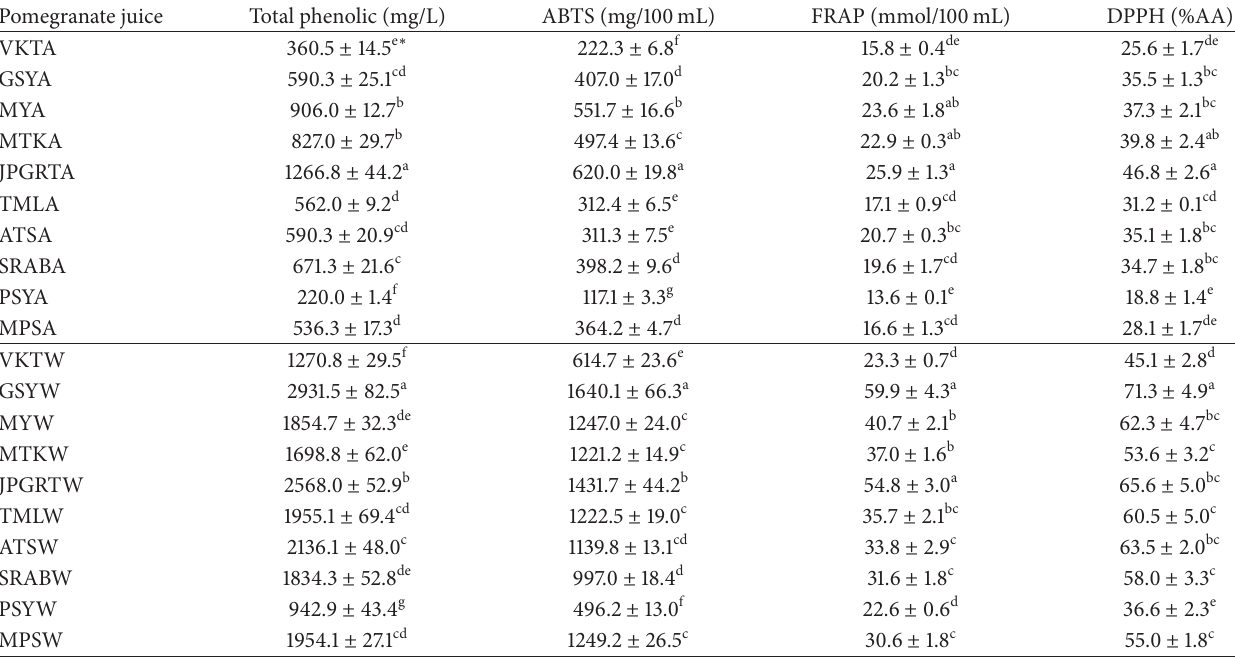
Table 3: Evaluation of total polyphenol content (mg gallic acid equivalents/L) and antioxidant activities based on ABTS (mg ascorbic acid/100 mL), FRAP (mmol Fe 2+ /100mL), and DPPH (%AA) in pomegranate